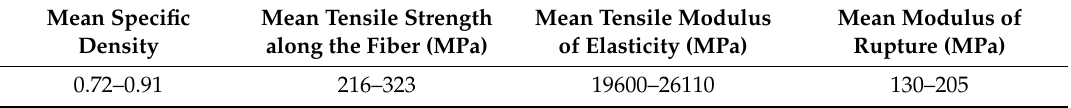
Table 4. Average properties of bamboo Dendrocalamus asper used in this study [34].